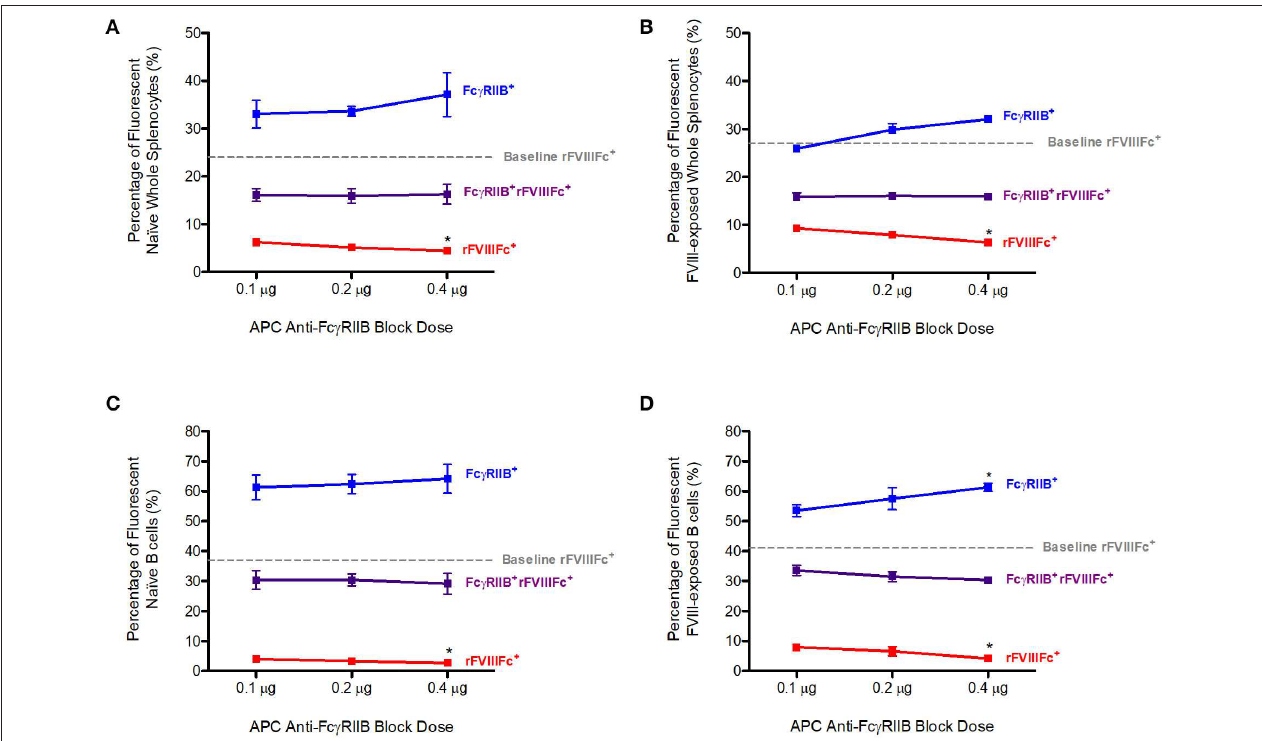
FIGURE 1 | Competition with anti-Fc γ RIIB decreases rFVIIIFc binding to naïve and FVIII-exposed splenocytes and B cells. The percentage of rFVIIIFc + , Fc γ RIIB + rFVIIIFc + and Fc γ RIIB + (A) naïve whole splenocytes, (B) FVIII-exposed whole splenocytes, (C) naïve B cells, (D) FVIII-exposed B cells when blocking with APC anti-Fc γ RIIB (0.1, 0.2, or 0.4 µ g) prior to YFP rFVIIIFc (0.3 µ g) incubation. Baseline rFVIIIFc corresponds to the percentage of rFVIIIFc + cells in the absence of APC anti-Fc γ RIIB. Statistical analysis compares the percentage of rFVIIIFc + , rFVIIIFc + Fc γ RIIB + , or Fc γ RIIB + cells at 0.2 and 0.4 µ g of block against the same parameter at 0.1 µ g of block. n = 3/condition. Error bars represent SD. * p <